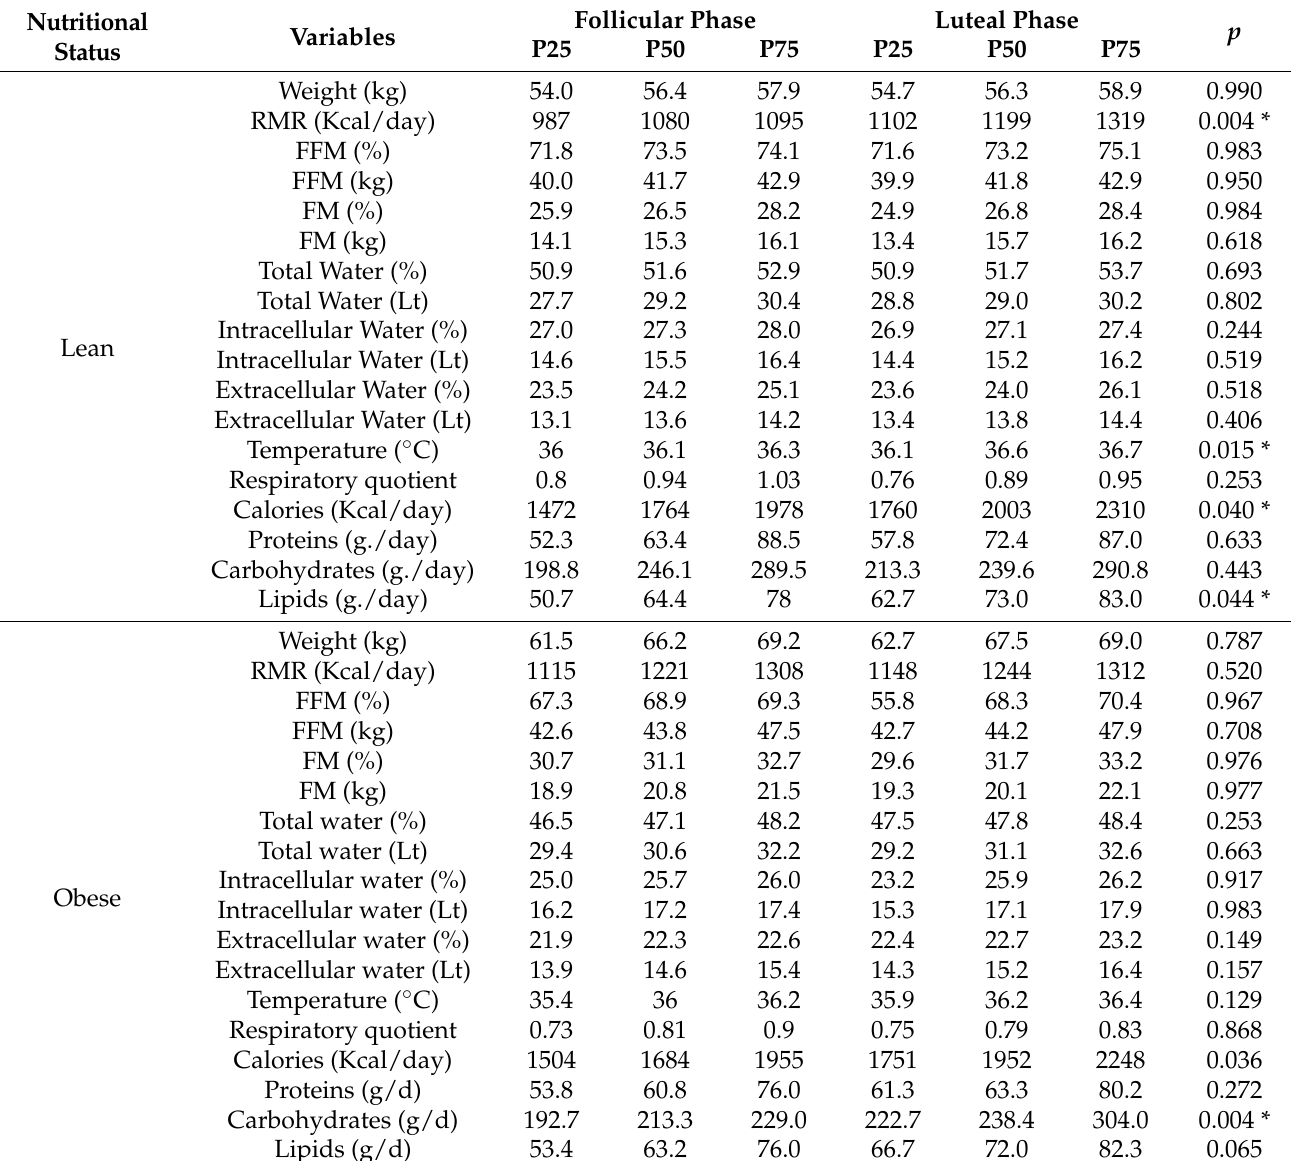
Table 1. Weight, rest metabolic rate, body composition, and nutritional intake of lean and obese women according to the menstrual cycle